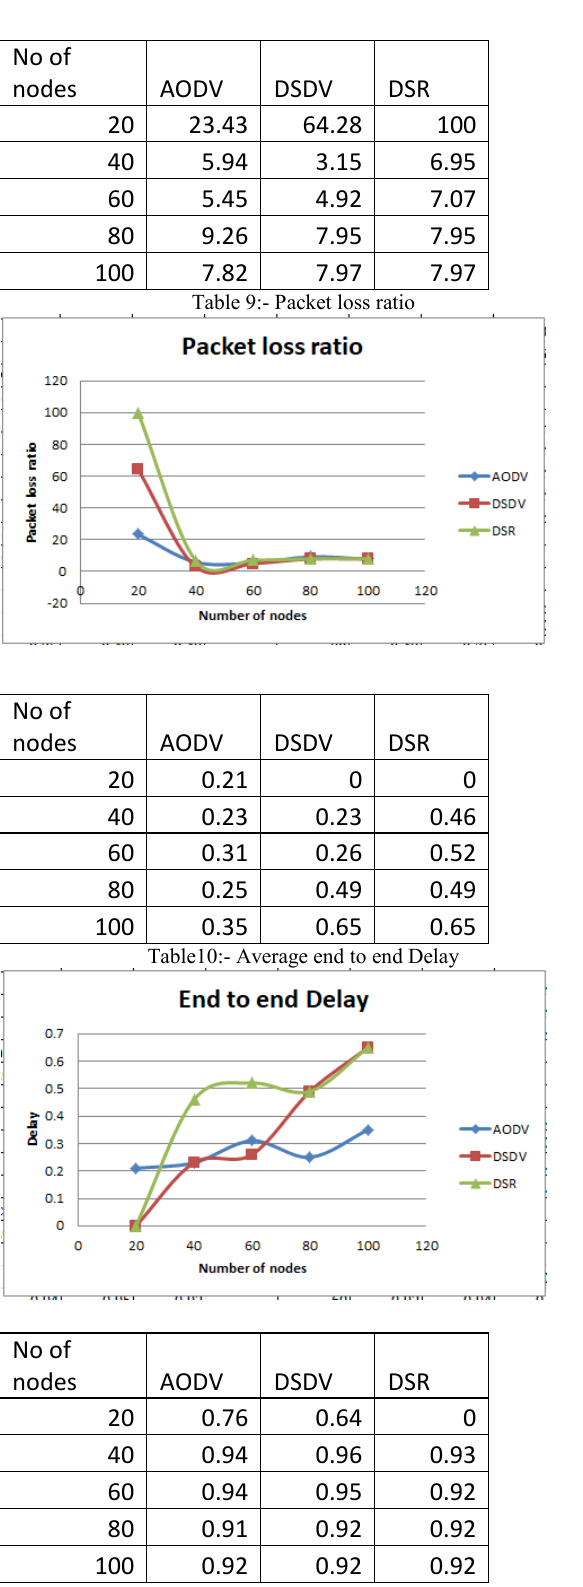
Table11:- Packet Delivery ratio